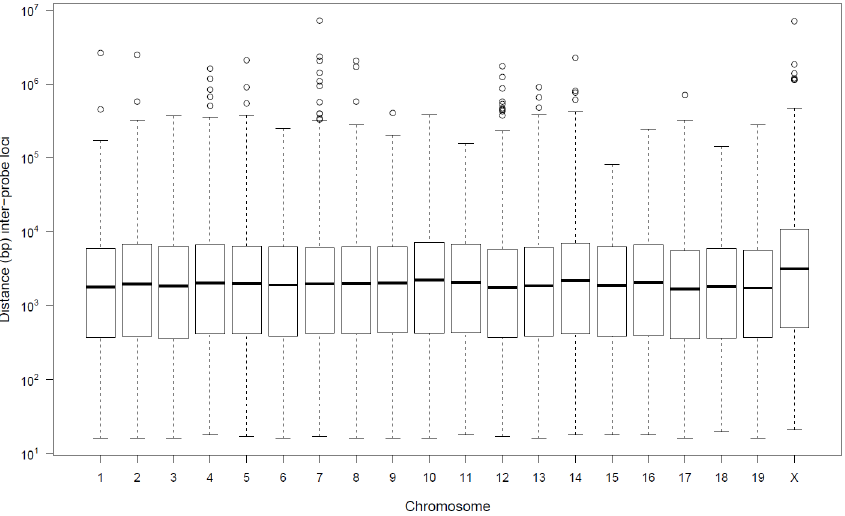
Fig 1. The inter-SNP locus distances (bp) for 493,290 SNP loci assayed by the probes on the Mouse Diversity Genotyping Array (MDGA) summarized for each chromosome. A boxplot of the distribution of inter-SNP locus distances (bp) for each autosome and the X